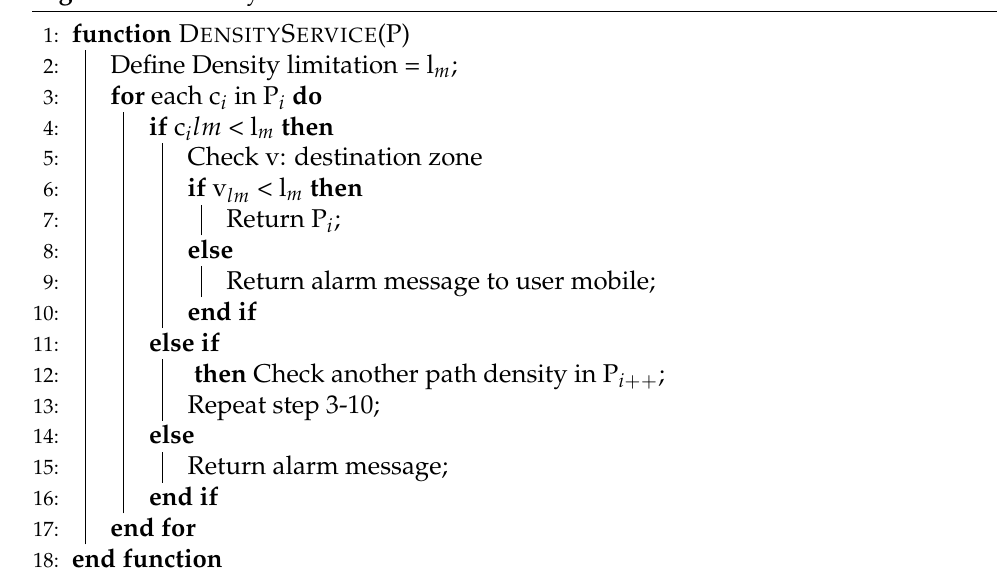
Algorithm 3 Density rule.